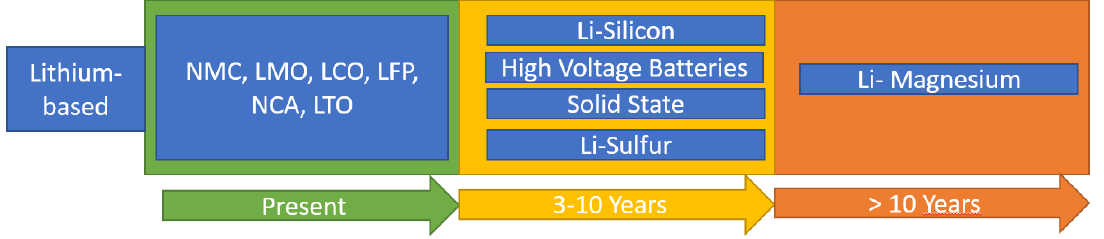
Figure 4. Roadmap of Lithium-ion based batteries from present up to >10